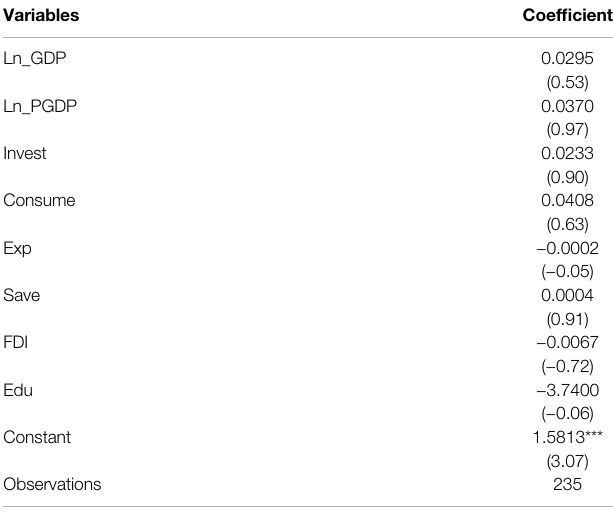
TABLE 3 | The risk regression model results. Z-statistics are reported in parentheses beneath the coef fi cients. Variables